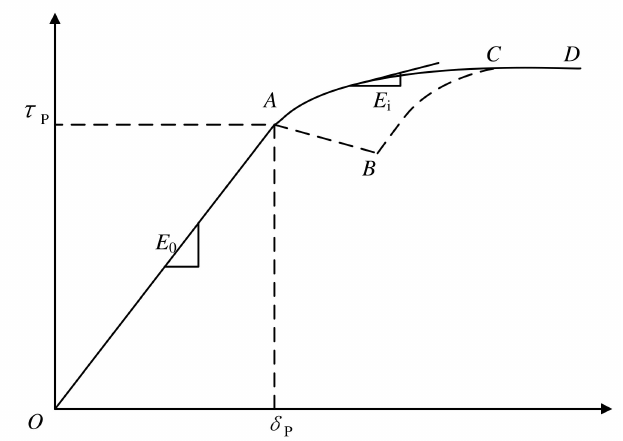
Figure 2. Falling τ - δ